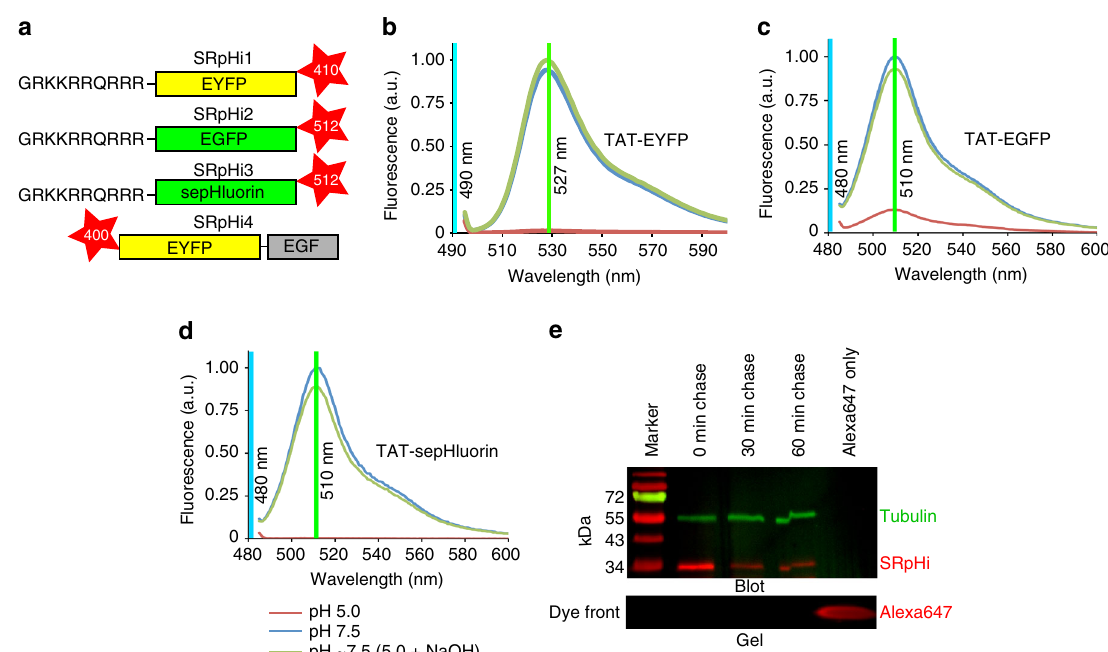
Fig. 1 SRpHi is a reversible and stable pH biosensor. a Diagrammatic representation of the SRpHi structure. SRpHi molecules consist of a fl uorescent protein backbone genetically fused to the cell-penetrating peptide TAT or epidermal growth factor (EGF). In addition, organic dye molecules are covalently attached via an amide linkage in a ~2:1 ratio. b – d Normalized fl uorescence emission spectra of TAT-EYFP b , TAT-EGFP c , or TAT-sepHluorin d were obtained from puri fi ed protein dissolved in citric acid/phosphate buffer of pH 7.5 ( blue line ) or 5.0 ( red line ). Spectra were then reacquired after addition of concentrated NaOH to return the pH 5.0 solution to ~pH 7.5 ( green line ). The wavelength of excitation light used for each experiment, and the fl uorescence maximum of each fl uorophore is indicated. e Pulse-chase experiments were performed using an EGFP-based SRpHi molecule conjugated to the far-red dye Alexa 647 (to prevent acquisition of signal arising from non-denatured EGFP). Lysates from MEF cells undergoing the indicated treatments were separated by SDS-PAGE and run alongside a molecular weight marker and free Alexa 647 dye. The dye-front of the gel was analyzed for far-red fl uorescence ( > 650 nm, red , bottom panel ) prior to transfer to PVDF membrane and immunolabelling ( top panel ). Primary antibodies against gamma-tubulin were visualized by reaction with secondary antibodies conjugated to Cy3 ( green ) and used as a loading control. SRpHi was visualized in the far-red spectrum, as the denatured protein did not emit fl